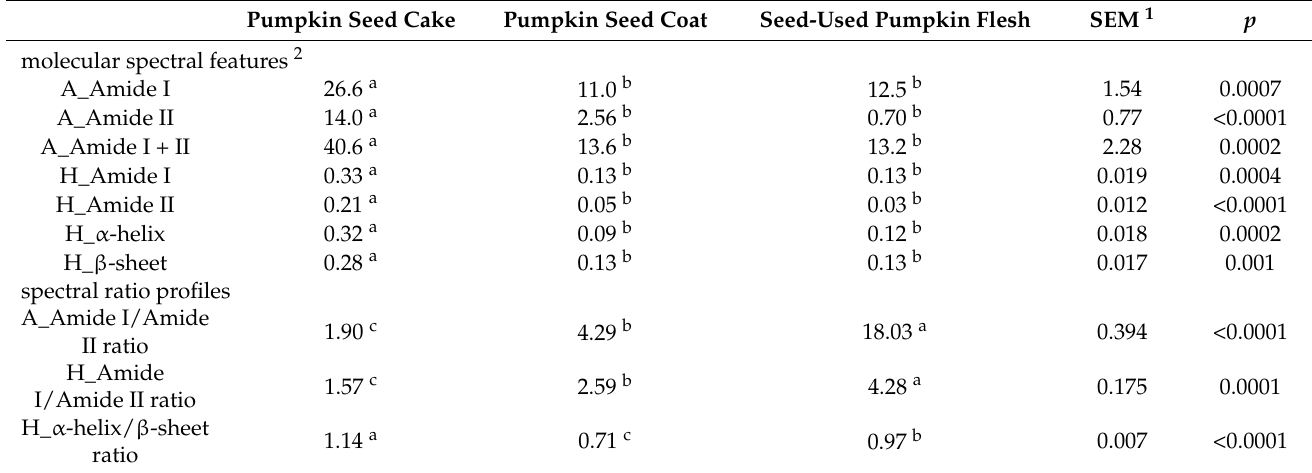
Table 3. Molecular structural characteristics of protein in different byproducts of seed-used